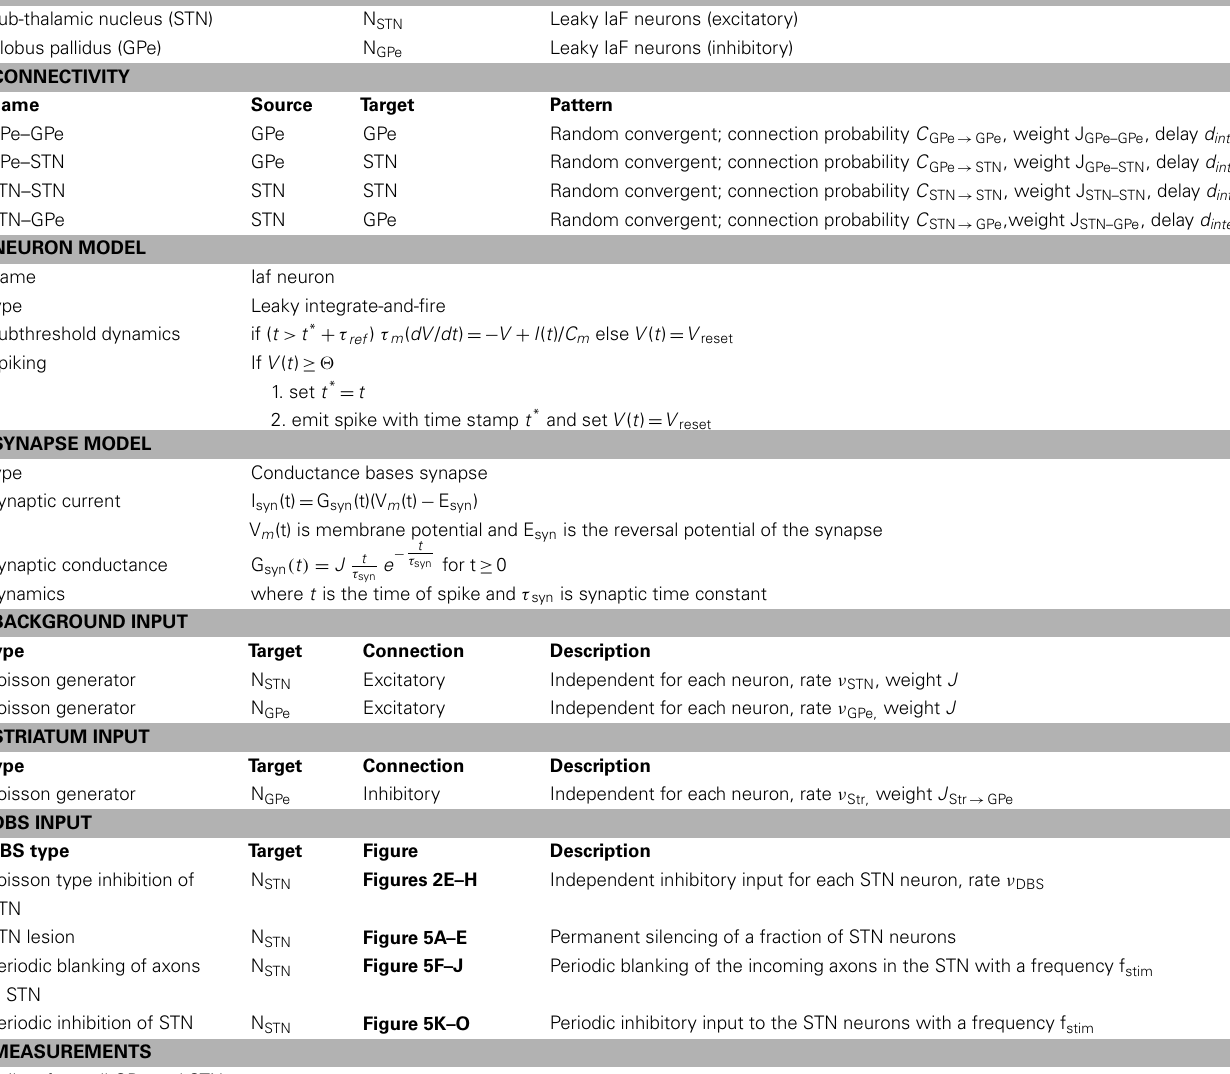
Table 1 |Tabular description of network model. NEURAL POPULATIONS Sub-thalamic nucleus (STN) N STN Leaky IaF neurons (excitatory) Globus pallidus (GPe) Leaky IaF neurons (inhibitory)